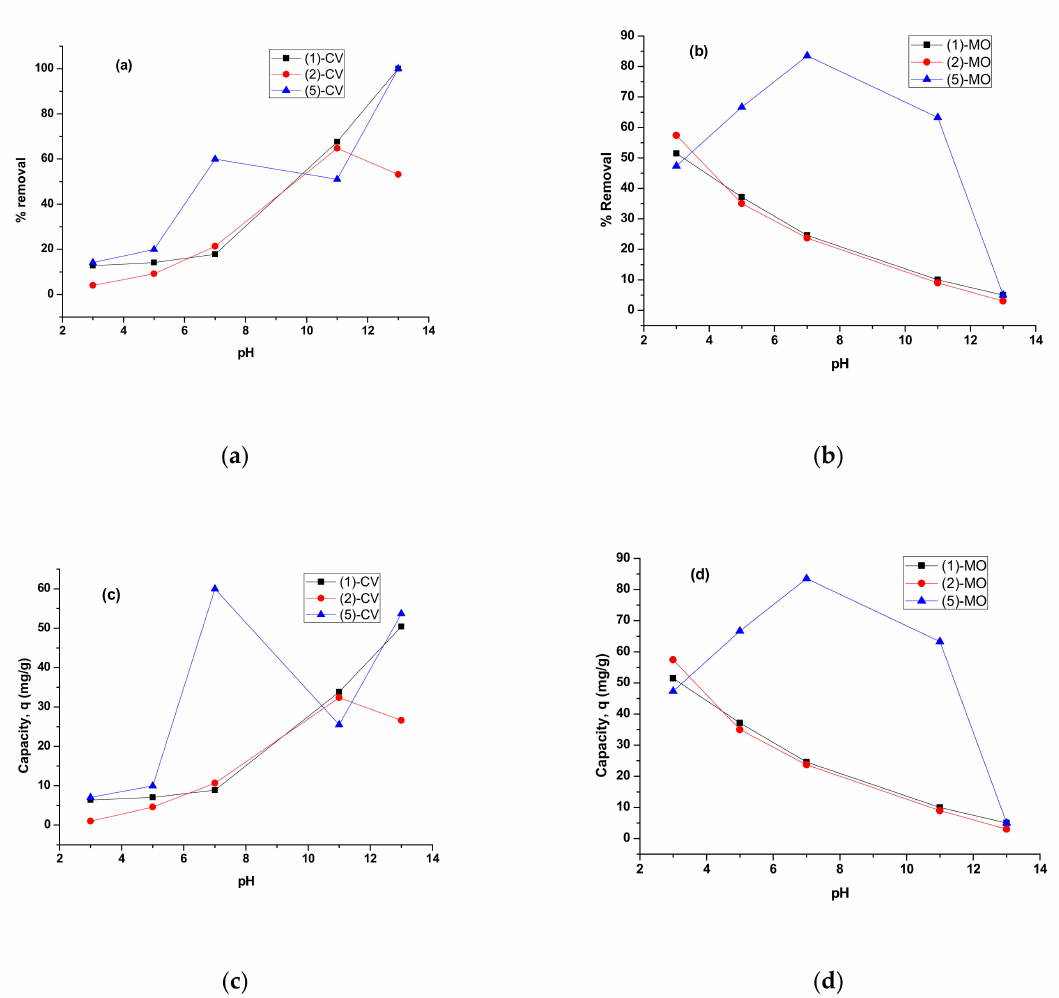
Figure 9. % removal of CV and MO dyes ( a ) and ( b ) and capacity q (mg/g) ( c ) and ( d ) by nanocomposites (1), (2) and (5) at different medium pH. (0.01 g adsorbent in 10 mL of dye solution MO (100 mg/L) or CV (50 mg/L), after 24